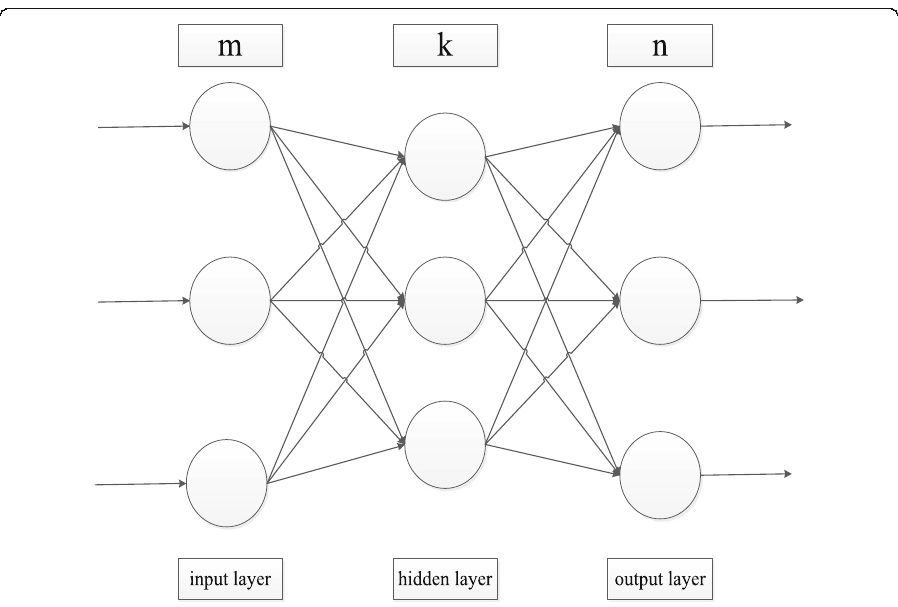
Fig. 1 Framework diagram of three-layer BP neural network